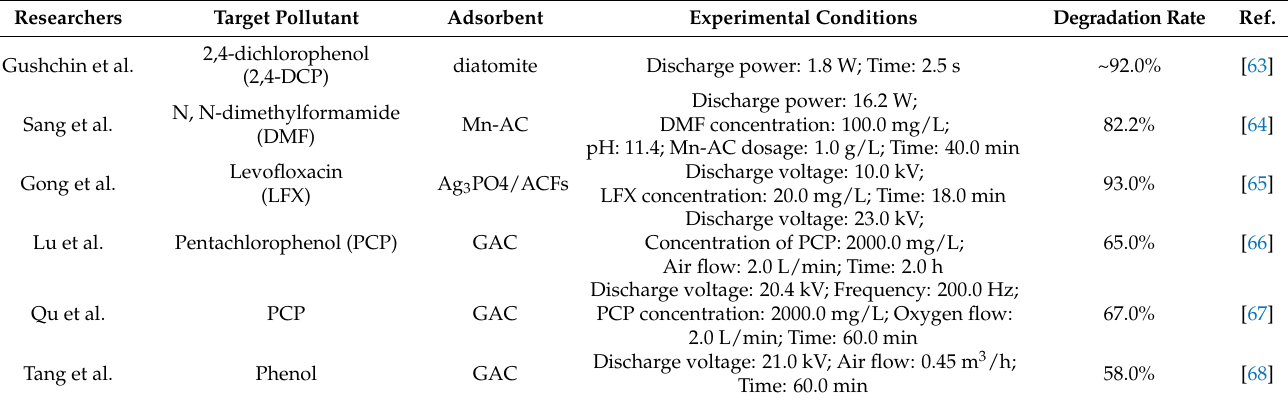
Table 2. Summary of DBD technologies with adsorption for the organic wastewater